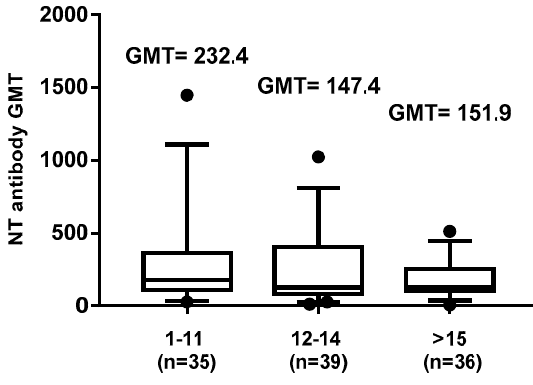
Figure 5. Time elapsed between the second dose of vaccine and the serological test (years). Effects of negative correlation based on the time elapsed between the second dose of measles vaccine and the last measles investigation test on neutralizing antibody response. The whiskers represent the values from the 5th to the 95th percentiles; the median, the 25th and 75th percentiles are depicted by the horizontal lines in the boxes. Individual data points are shown; outlier values are shown as black circles. GMTs are shown above the population columns. P -value of the GMT between the first (1–11) and second (12–14) group is < 0.05.